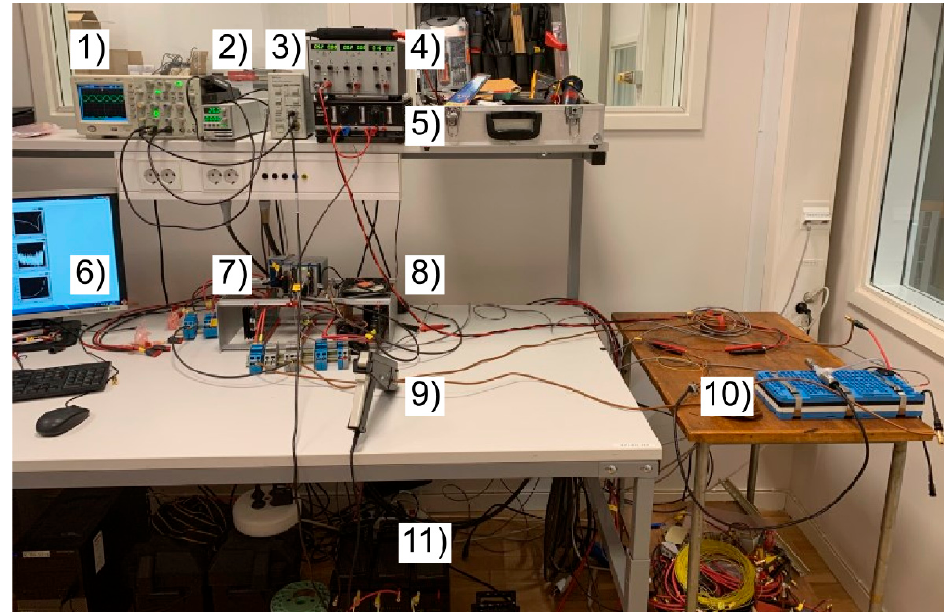
Figure 1. Experimental setup: ( 1 ) Oscilloscope DS0 1024A (Keysight Technologies, Santa Rosa, CA, USA), ( 2 ) Power supply (TDK-Lambda, Tokyo, Japan), ( 3 ) Current amplifier TCPA300 (Tektronix, Beaverton, OR, USA), ( 4 ) Power supply (24 V DC), ( 5 ) Power supply (± 5 V DC), ( 6 ) PC with LabVIEW (2018), [24] ( 7 ) Measurement equipment NI cDAQ, ( 8 ) VSC, ( 9 ) Current probe A622 (Tektronix, Beaverton, OR, USA), ( 10 ) NiMH battery, under test, ( 11 ) Energy buffer (lead-acid battery).